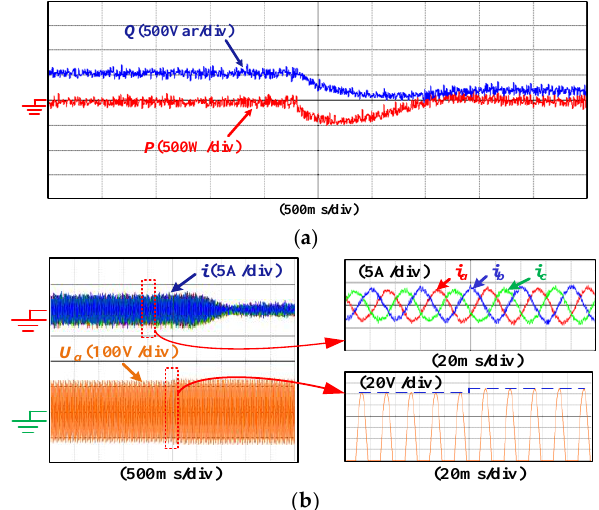
Figure 14. Experimental waveform of power and current when the voltage increases. ( a ) Power mutation waveform when voltage increases; ( b ) current mutation waveform when voltage increases.